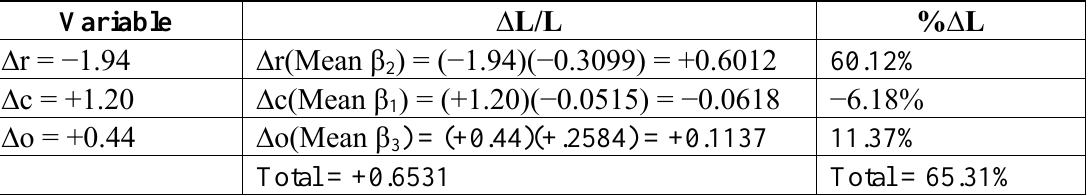
Table 6. Impacts on %∆L of Restoration of r, c and o to 8/2008